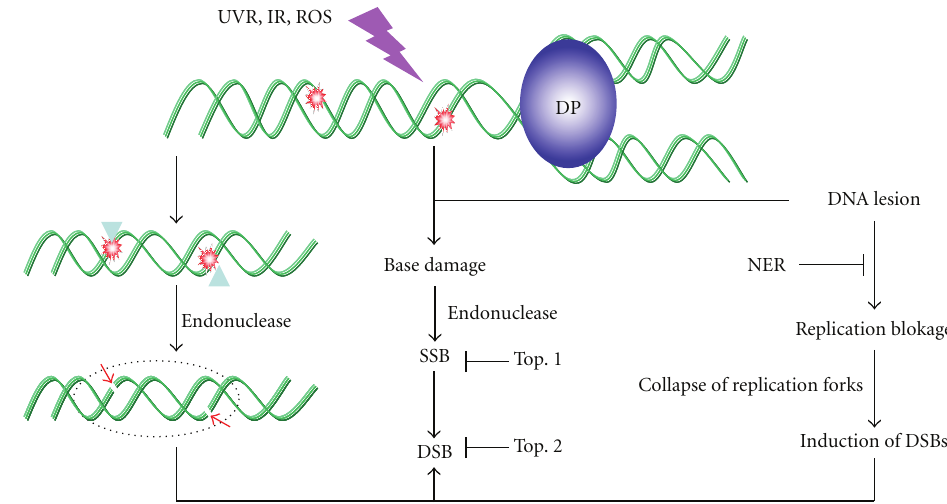
Figure 8: Schematic representation showing di ff erent pathways of